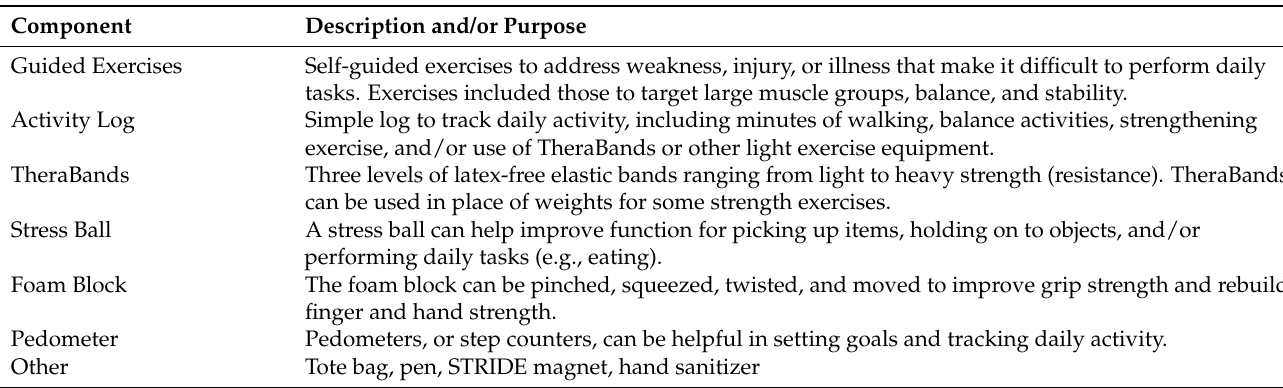
Table 1. Components of the SiYR